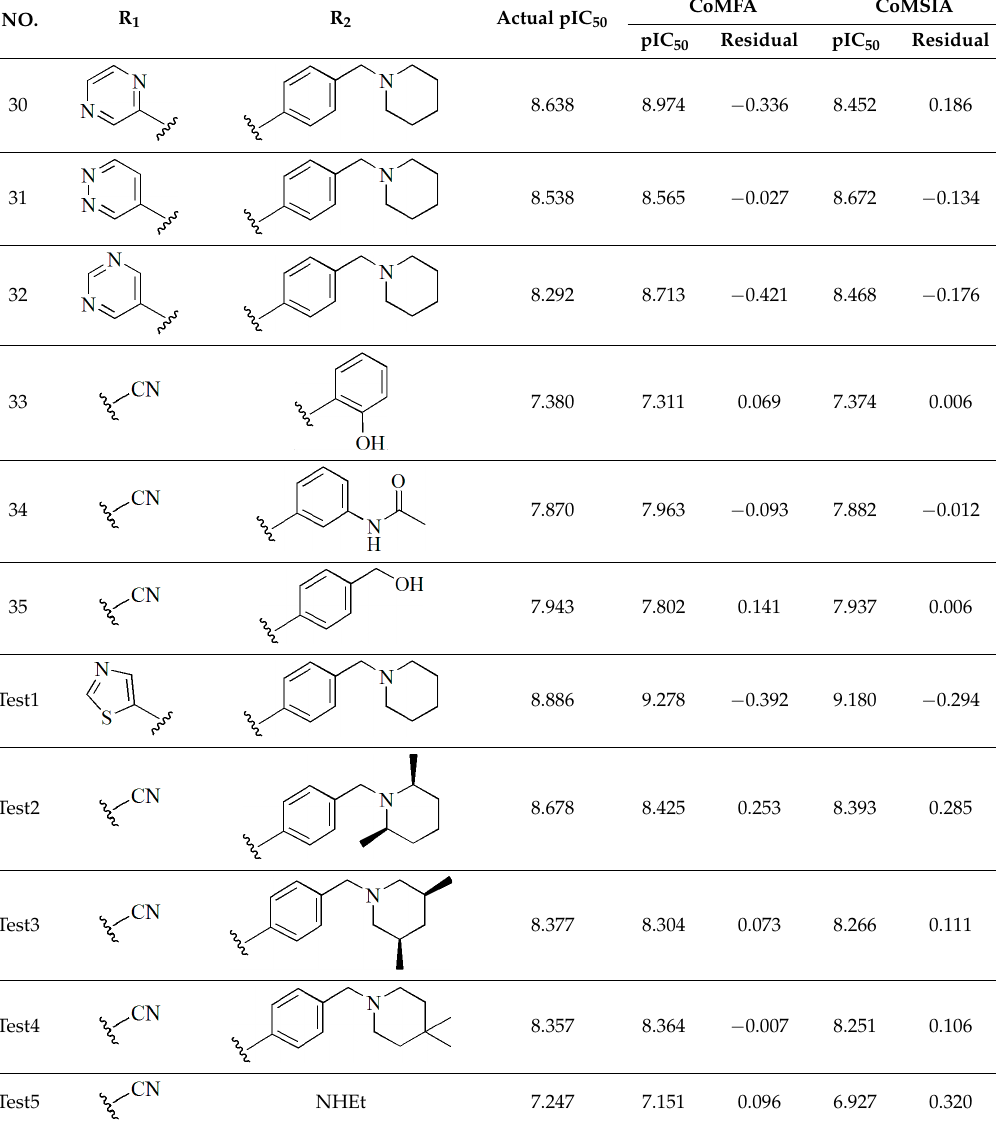
Table 1. Chemical structural formulas of all structures. Statistical parameters of the actual and predicted bioactivity by CoMFA and CoMSIA, as well as the residual between the actual and predicted pIC 50 values. All the aligned molecular dataset used for the 3D QSAR studies were shown in Table S1 in the supplementary materials